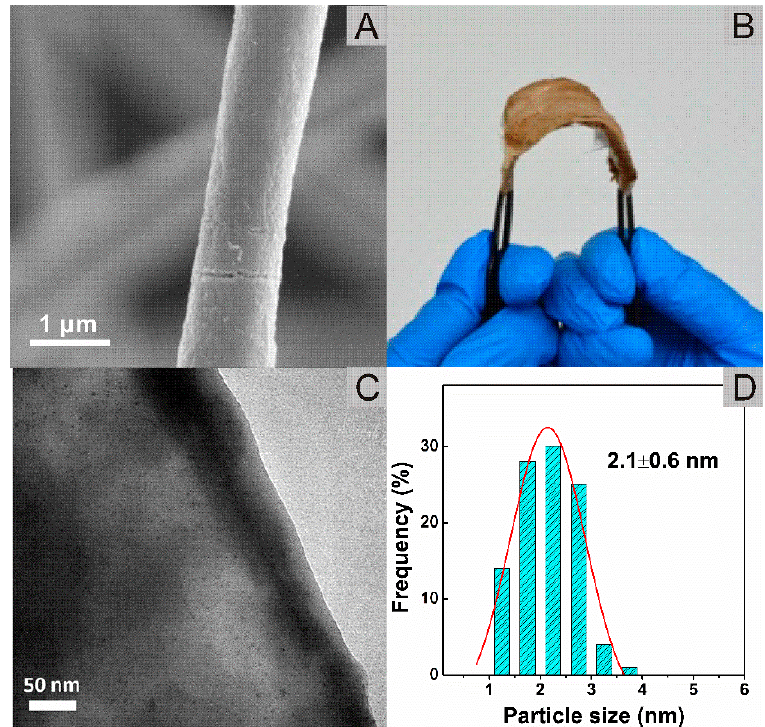
Figure 3. SEM images of PtNi/PMMA@PDA nanofilm (A); the digital photo of the PtNi/PMMA@PDA- 1/10 nanofibrous membrane (B); TEM image of PtNi/PMMA@PDA-1/10 nanofibrous membrane (C); Corresponding size distribution of the supported PtNi nanoparticles